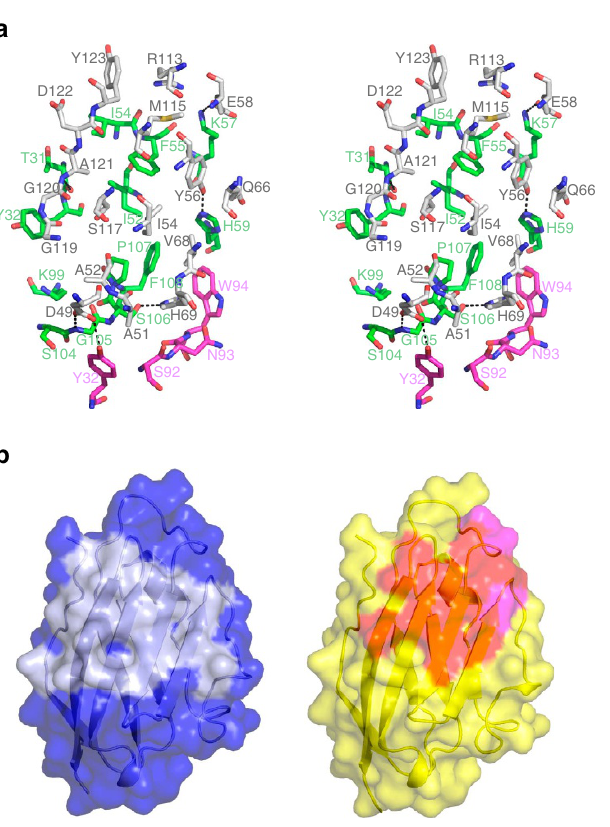
Figure 5 | Interaction between PD-L1 and BMS-936559. ( a ) Stereoview of the detailed PD-L1/BMS-936559 interface. The carbon atoms of PD-L1 and heavy and light chain of BMS-936559 are coloured grey, green and purple, respectively. Hydrogen bonds and a salt bridge are indicated with dashed lines. ( b ) Surface representations of the PD-L1 molecules in the complex structures of PD-1/PD-L1 (left) and PD-1/BMS-936559 (right). The surface of PD-L1 in PD-1/PD-L1 is coloured blue and the PD-1 binding site on the surface of PD-L1 is coloured pale blue. The surface of PD-1 in PD-1/BMS- 936559 is colored yellow. The epitope regions for the heavy and light chain of BMS-936559 are coloured red and purple, respectively.